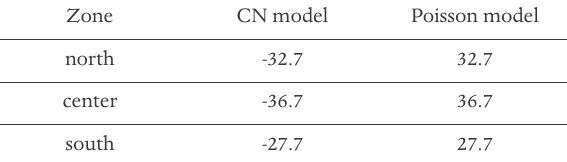
Table 4. Parimutuel gambling score results (bold italic for the best